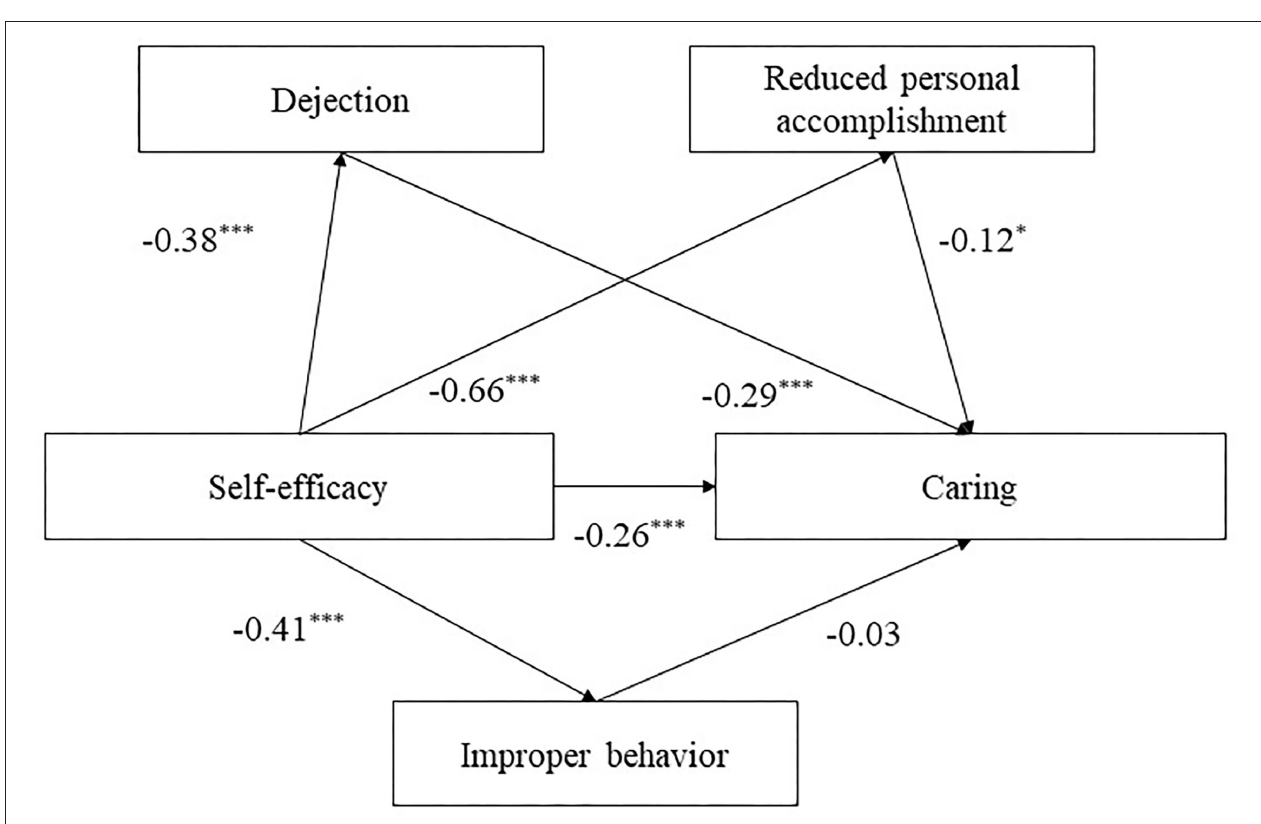
FIGURE 2 | The structural model of self-efficacy, dejection, reduced personal accomplishment and improper behavior on caring. Significant paths are presented by asterisks (* p < 0.05, ** p < 0.01, *** p <